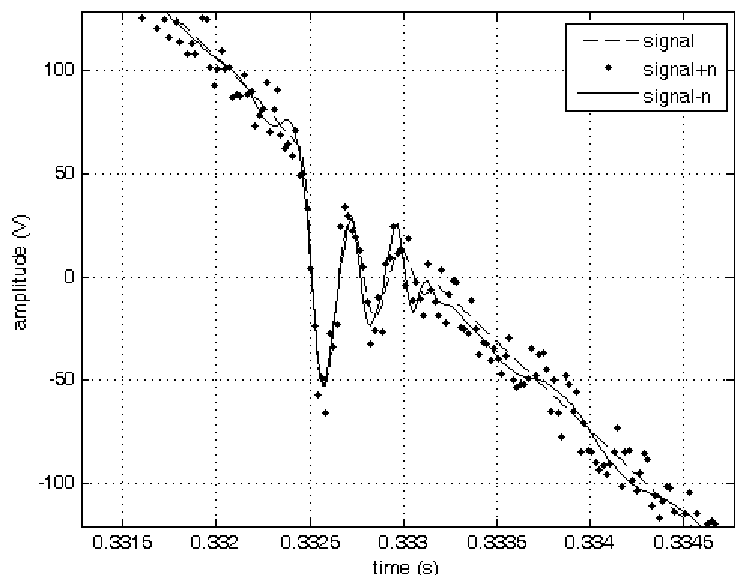
Figure 16. Detail of noise reduction from burst signal. Original signal is presented with dashed line, signal with noise is marked by dots and signal after noise reduction is presented with solid